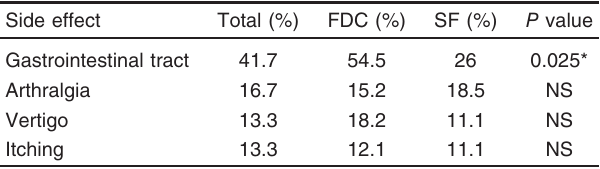
Table 3 Important antituberculosis drugs-induced adverse effects Side effect